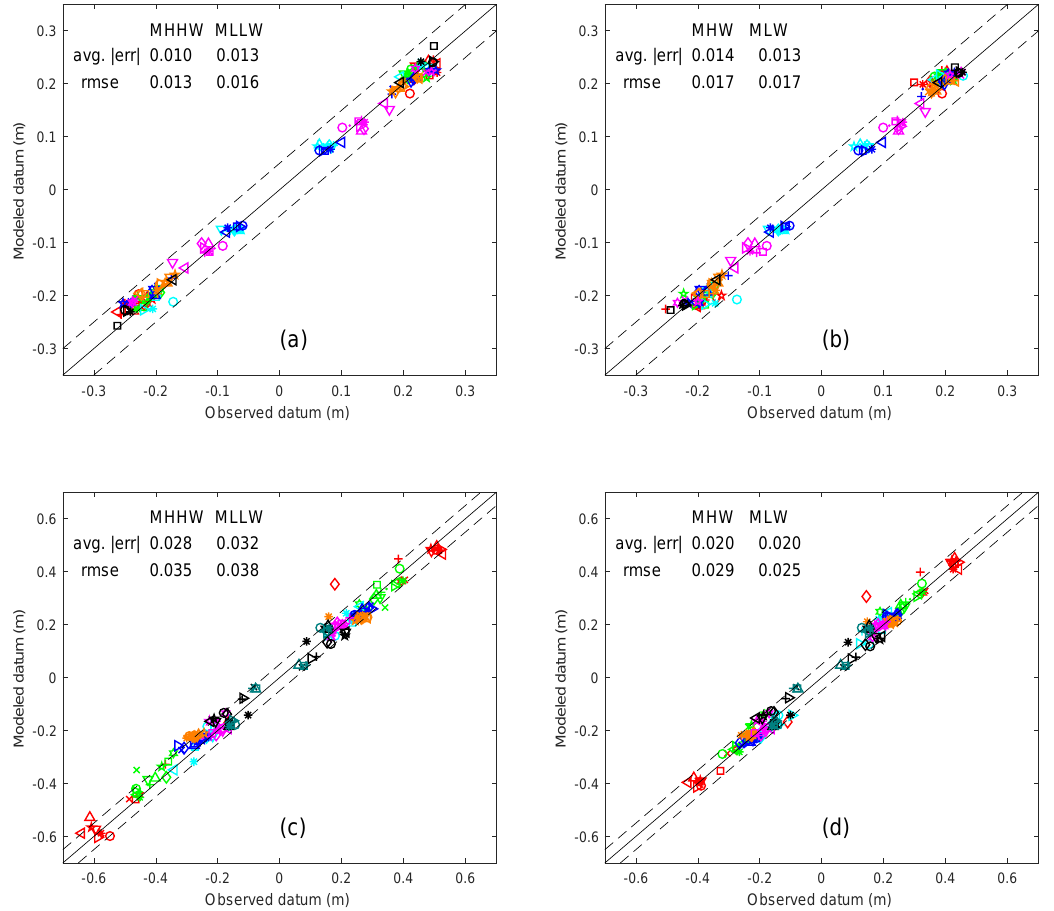
Figure 6. Comparison of the modeled tidal datum and observations for tide stations ( a , b ) within and ( c , d ) outside the VDatum region. The dashed lines indicate the 5-cm error band. The maximum model errors in the VDatum region are 0.033, 0.042, 0.054 and 0.073 m for MHHW, MLLW, MHW, and MLW, respectively. Two of them, MHW at station 8728958 and MLW at